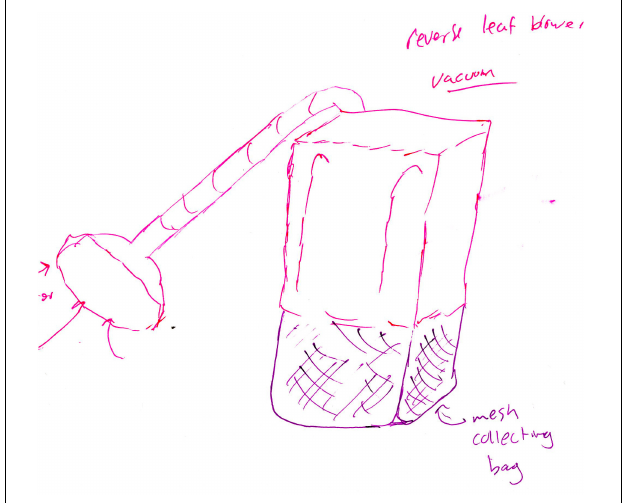
FIGURE 2 | A backpack vacuum that received an originality score of 0.